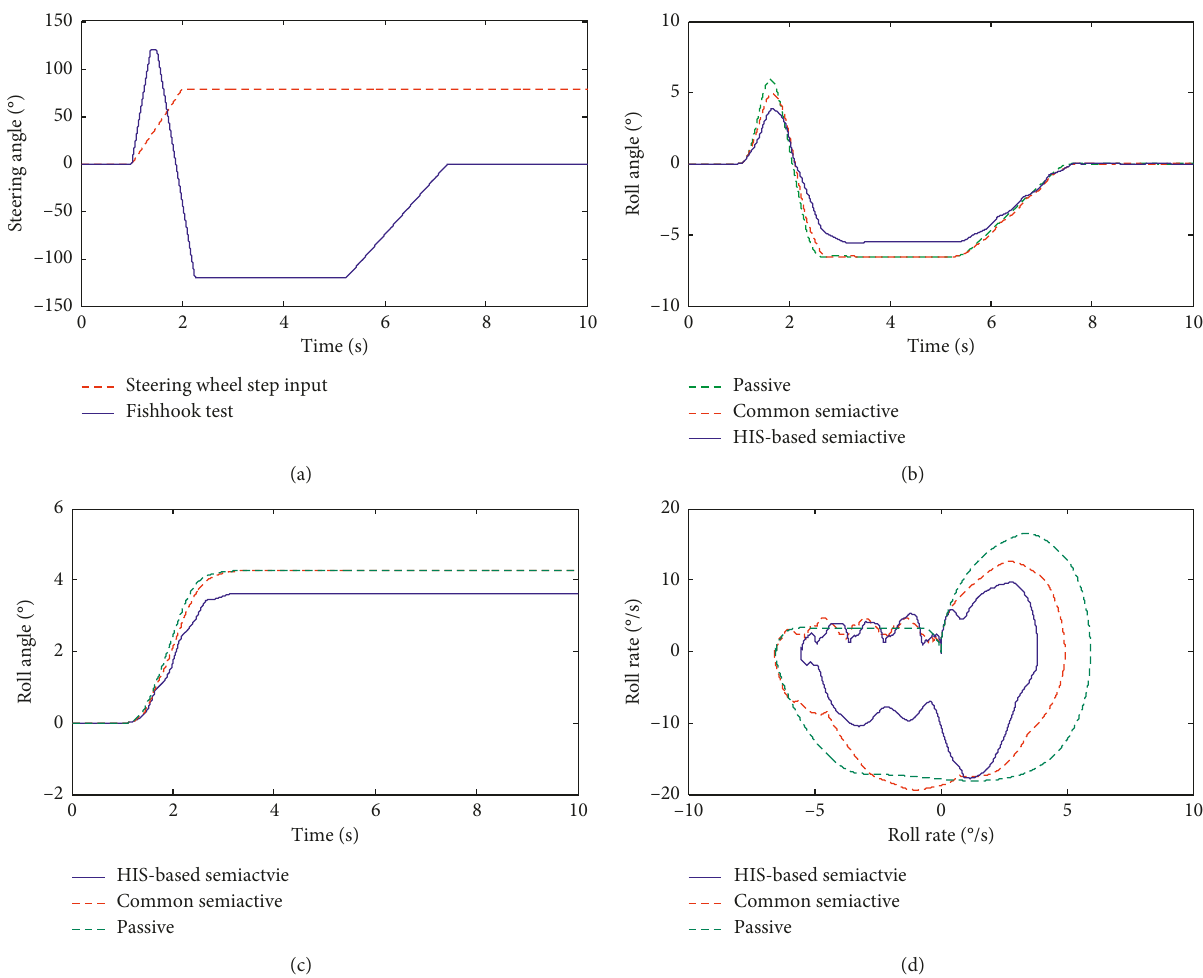
Figure 19: Comparison of roll angle-roll rate phase-plane for the fishhook test. (a) Steering input. (b) Roll angle for fishhook test. (c) Roll angle for step input steering. (d) “Roll angle-Roll rate” phase-plane for fishhook